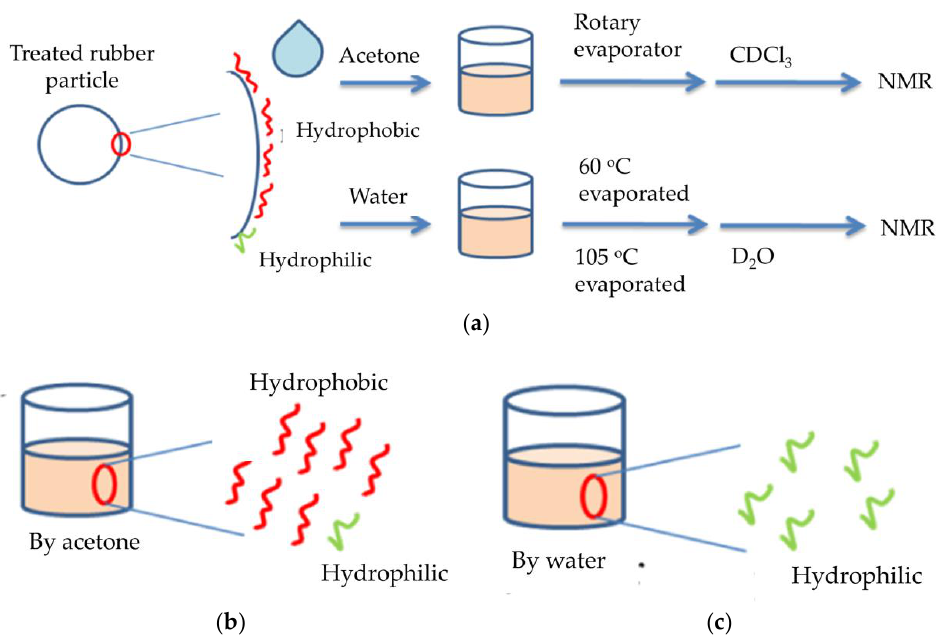
Figure 2. Extraction of absorbing pyrolysis oil for NMR analysis. ( a ) Extraction procedure; ( b ) components extracted with acetone; ( c ) components extracted with water. Red line: hydrophobic components; green line: hydrophilic components.